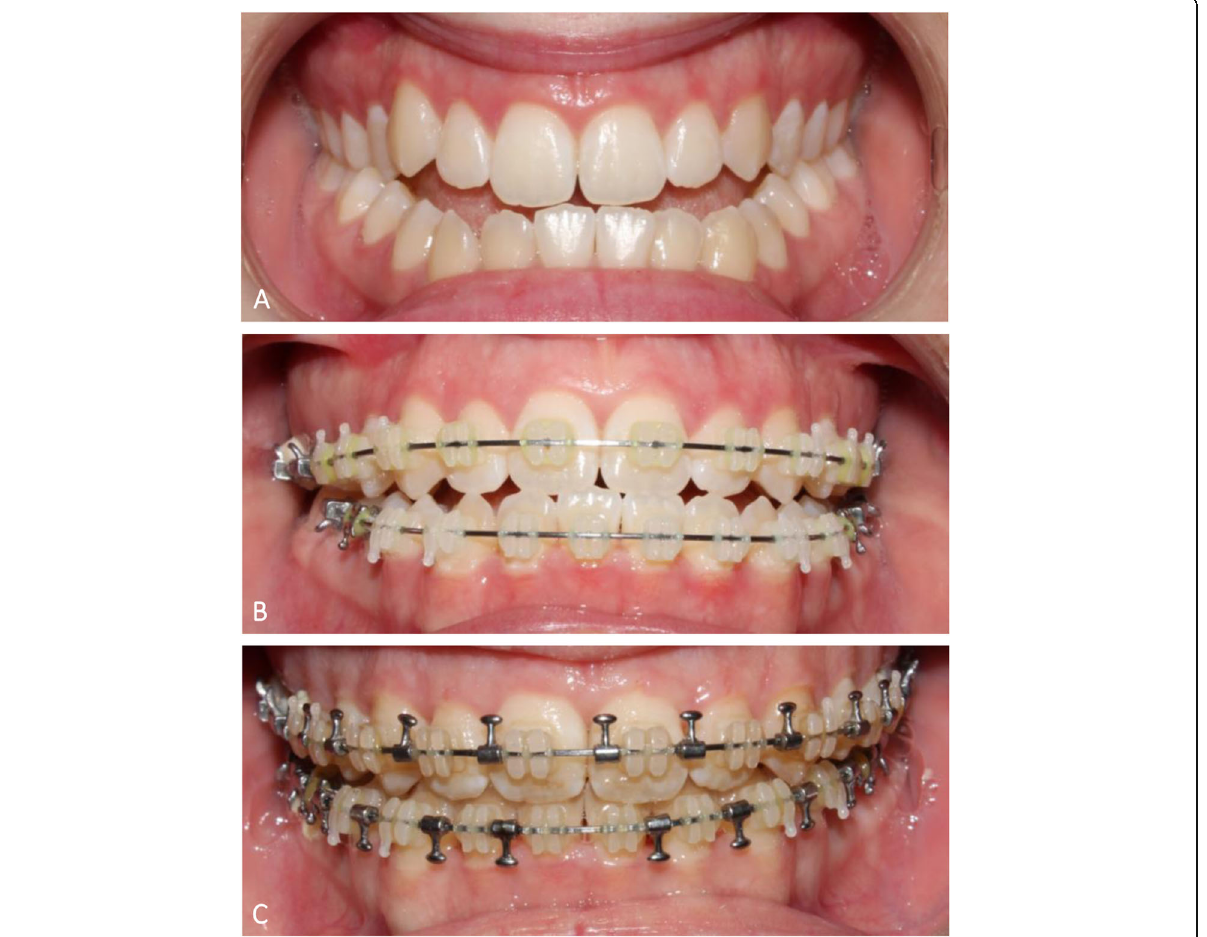
Fig. 1 Occlusion photos from A before orthodontics, B preoperative, and C 6 weeks